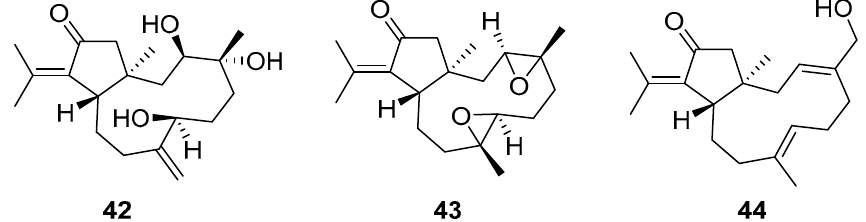
Figure 18. Structures of semi-synthesized oxygenated dolabellanes ( 42 – 44 ) originally isolated from the Caribbean octocoral Eunicea laciniata .